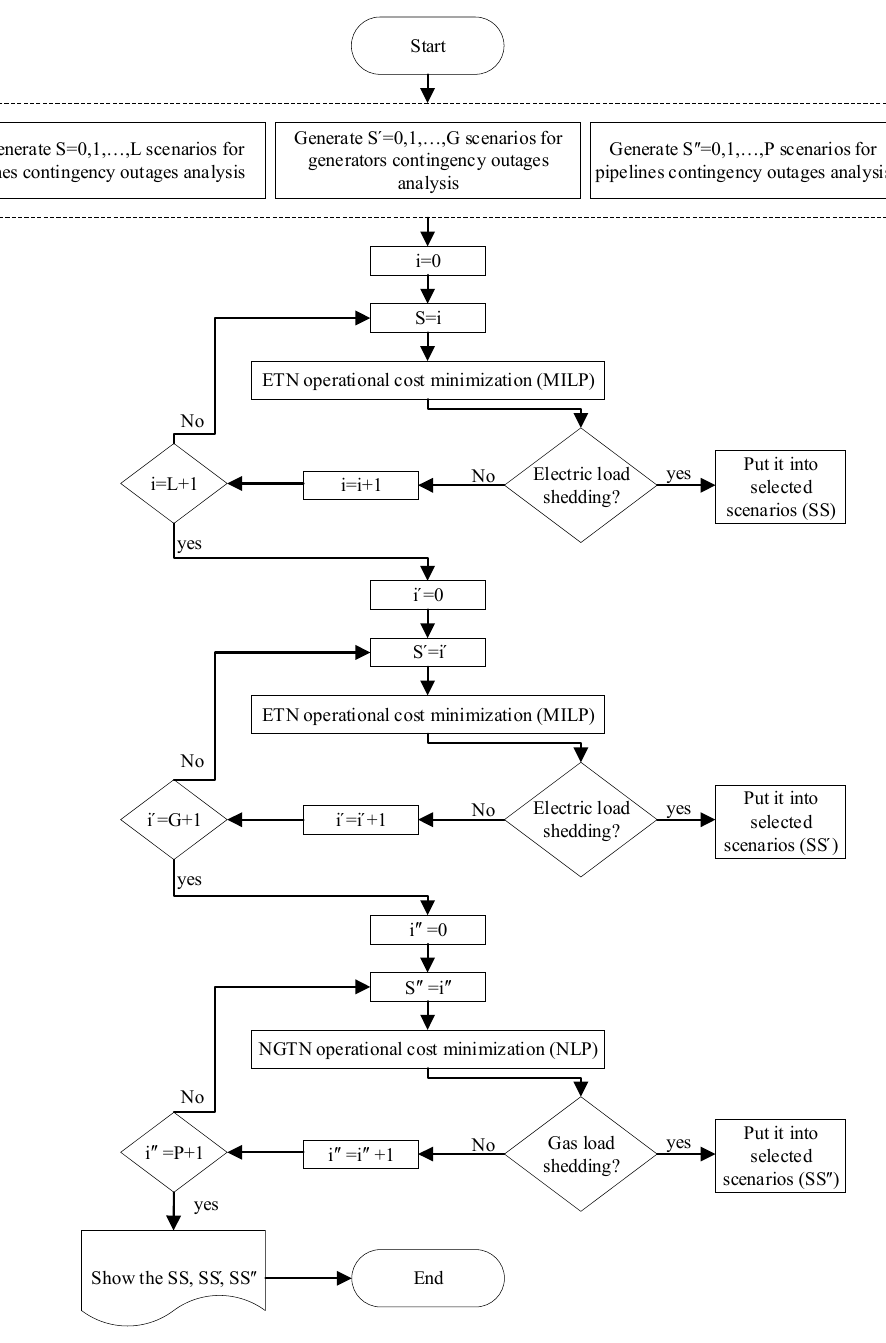
Figure 2. Flowchart of the proposed algorithm.